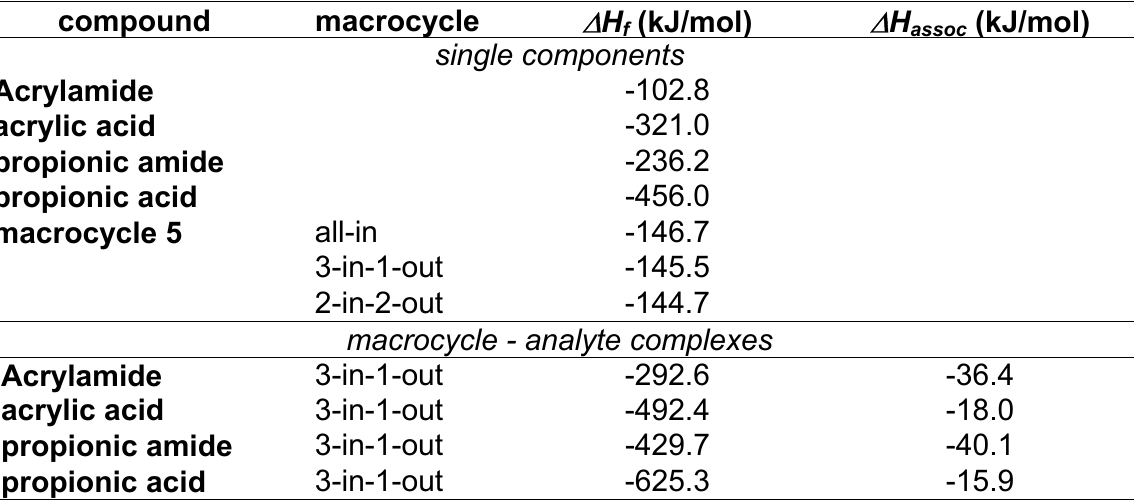
Table 1. Heats of formation ∆ H unsubstituted tetralactam macrocycle calculated at the AM1 level of